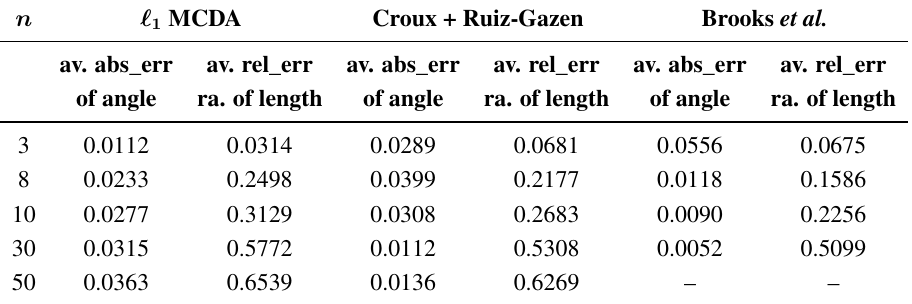
Table 1. The results of (cid:96) MCDA and Robust PCAs on one Gaussian distribution. 1